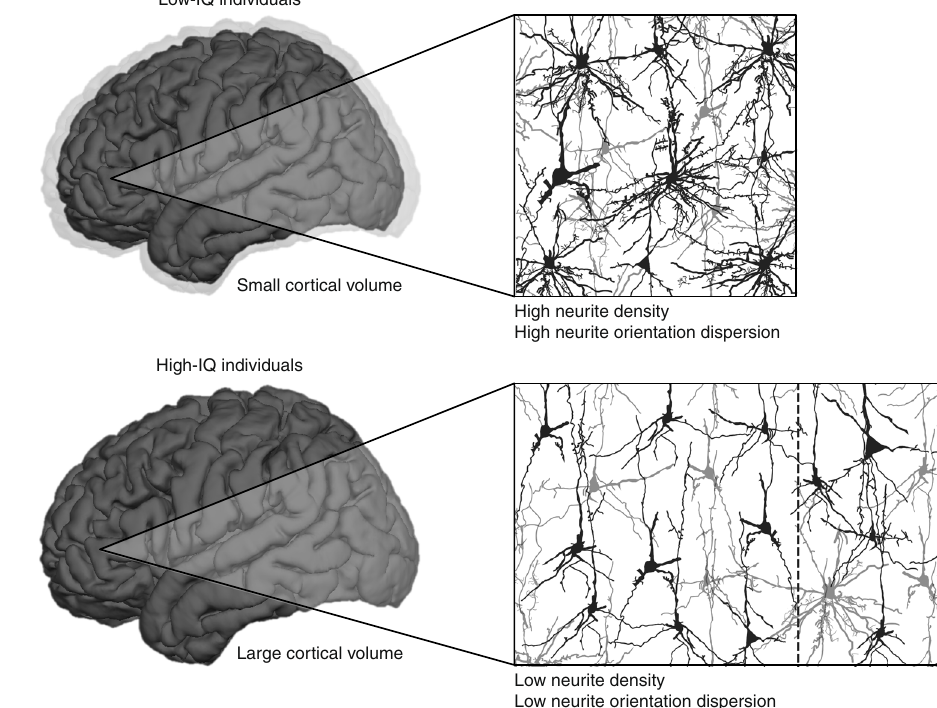
Fig. 4 Schematic depiction of differences between low-IQ and high-IQ individuals with regard to brain volume, neurite density, and arborization of dendritic trees within the cortex. High-IQ individuals are likely to possess more cortical volume than low-IQ individuals, which is indicated by differently sized brains (left side) and differently sized panels showing exemplary magni fi cations of neuron and neurite microstructure (right side). The difference in cortical volume is highlighted by the shadow around the upper brain. Due to their larger cortices, it is conceivable that high-IQ individuals bene fi t from the processing power of additional neurons, which are marked by the dotted line in the lower panel. The cerebral cortex of high-IQ individuals is characterized by a low degree of neurite density and orientation dispersion, which is indicated by smaller and less rami fi ed dendritic trees in the respective panel. Intellectual performance is likely to bene fi t from this kind of microstructural architecture since restricting synaptic connections to an ef fi cient minimum facilitates the differentiation of signals from noise while saving network and energy resources. Neurons and neurites are depicted in black and gray to create a sense of depth. Please note, this depiction does not correspond to the actual magnitude of effect sizes reported in the study. For the purpose of an easier visual understanding, differences in both macrostructural and microstructural brain properties are highly